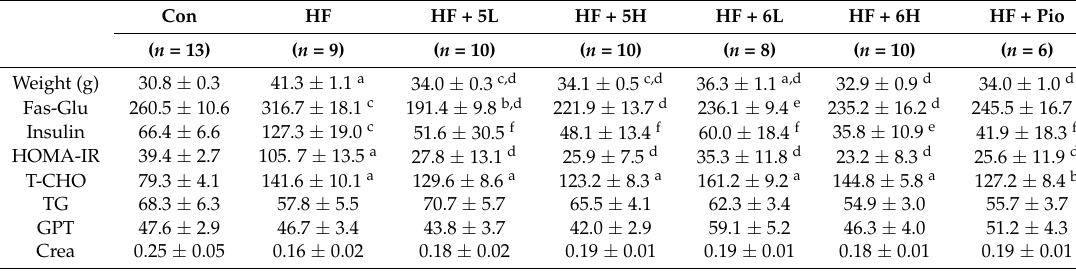
Table 1. Biochemical data of the mice in preventive